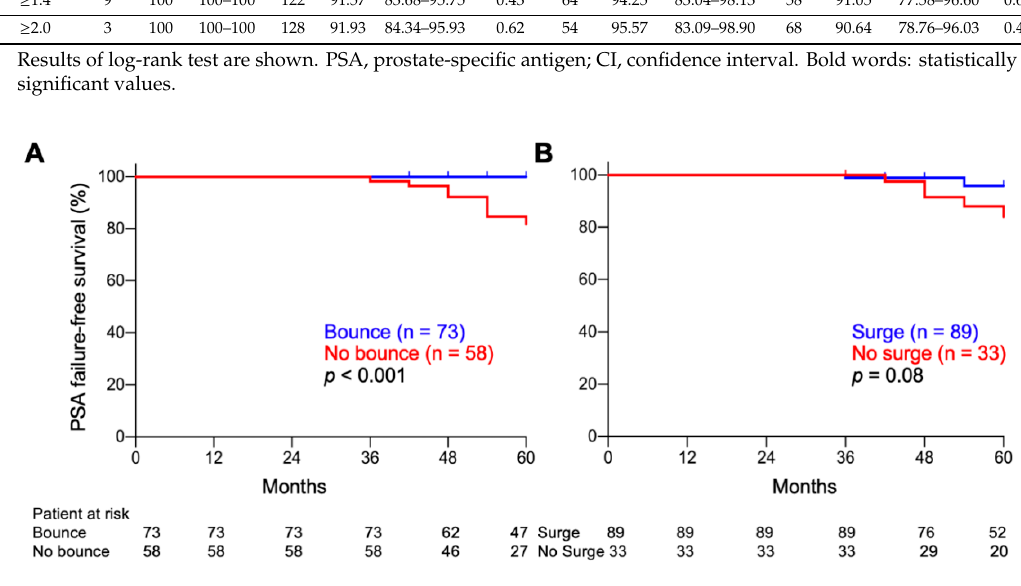
Figure 3. Kaplan–Meier estimates of PSA failure-free survival. ( A ) PSA bounce-positive vs. -negative patients. ( B ) PSA surge-positive vs. -negative patients. Cutoff, 0.2 ng/mL. p -values were determined by log-rank test.